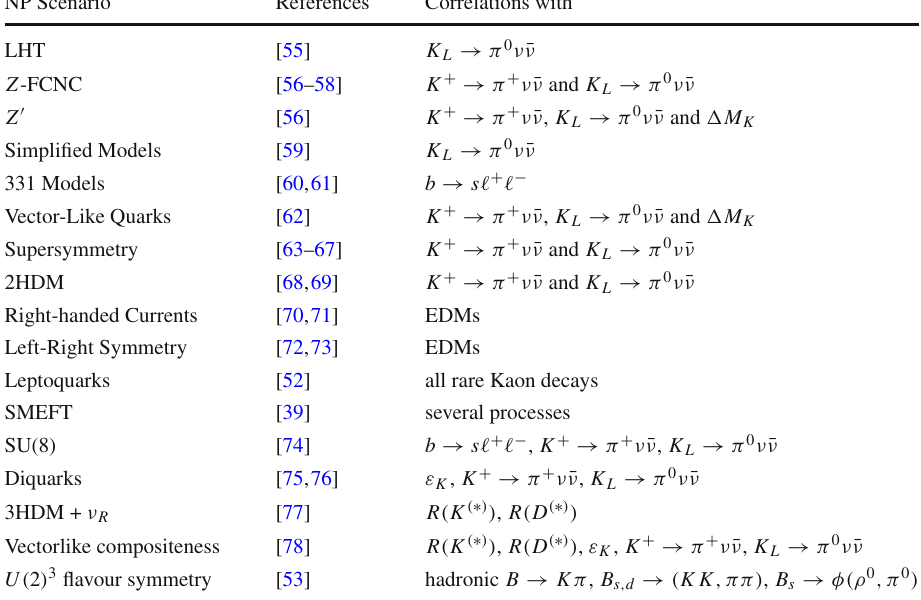
implications of the ε (cid:2) /ε